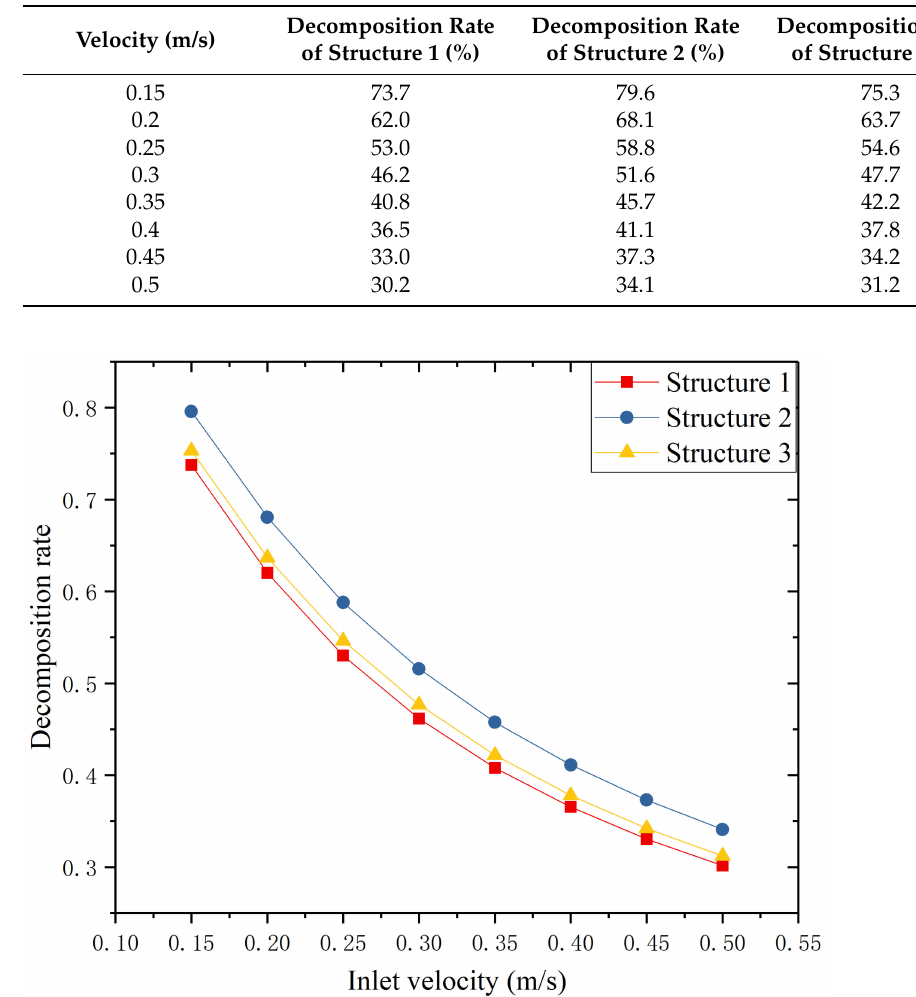
Table 4. Numerical calculation results of decomposition rates at different velocities.